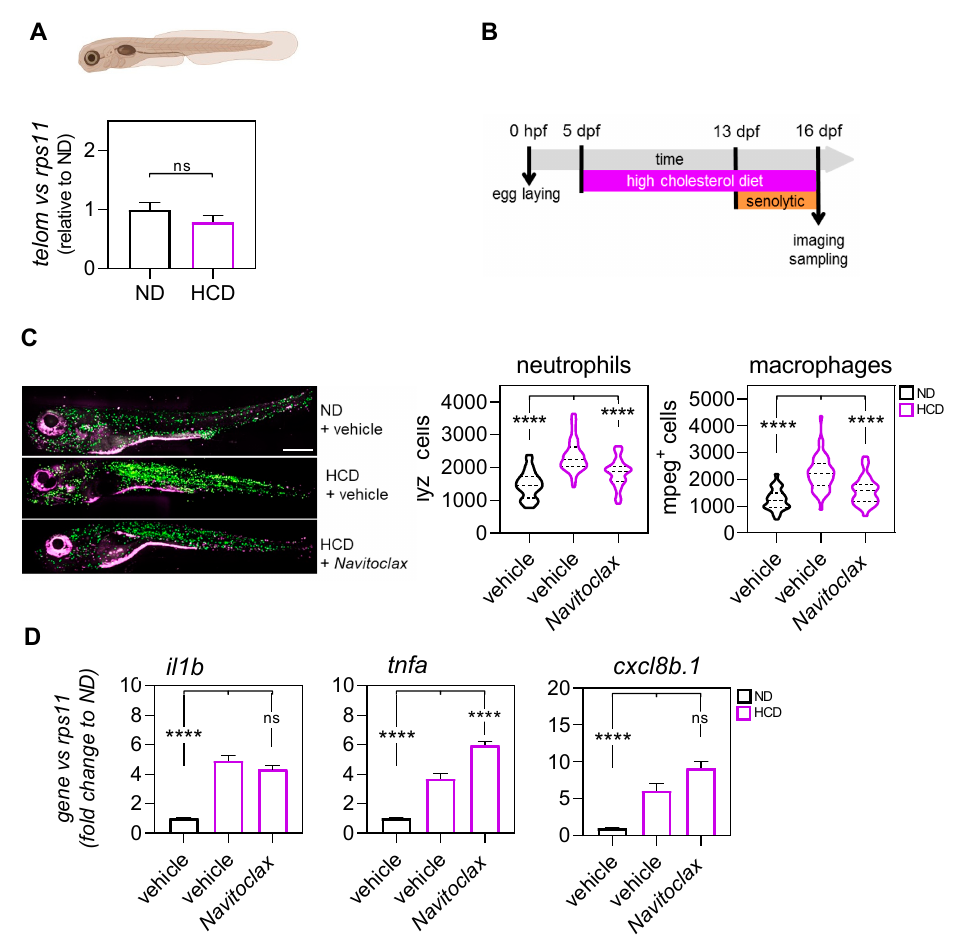
Figure 3. Evaluation of the anti-inflammation effect of navitoclax in the high-cholesterol diet (HCD)-induced metainflammation zebrafish model. ( A ) The telomere length was measured in 16 dpf zebrafish larvae by qPCR using 40 ng of gDNA and determined as the telomere content relative to the single copy gene rps11. The graph shows the mean ± SEM of 25 pooled larvae ( n = 25) and triplicate samples from 3 independent experiments ( n = 3). ND (normal diet). HCD (high-cholesterol diet). ( B ) General workflow for the treatment with navitoclax of the zebrafish model with metainflammation induced by HCD. ( C ) Representative images and quantification of the total number of neutrophils (purple) and macrophages (green) of 16 dpf (lyz:DsRED2; mpeg1:EGFP) larvae after 3 days of treatment with navitoclax. The violin plots with the median shown as a horizontal line show the distribution of DsRED2 + and EGFP + cells and are overlaid with the raw data, where each dot represents an individual. ( D ) The mRNA level of il1b, tnfa, and cxcl8b.1 were determined by RT-qPCR and normalized against rps11 in 16 dpf larvae after treatment. The bars show the mean ± SEM of 20 pooled larvae ( n = 20) and triplicate samples from 2 independent experiments ( n = 2). ns, non-significant; **** p < 0.0001, according to Kruskal-Wallis followed by Dunn’s multiple comparison test ( A ), two-way ANOVA followed by Dunnett’s multiple comparison test ( C ), and Brown-Forsythe ANOVA followed by Dunnett’s T3 multiple comparison test ( D ). Scale bars, 500 µ